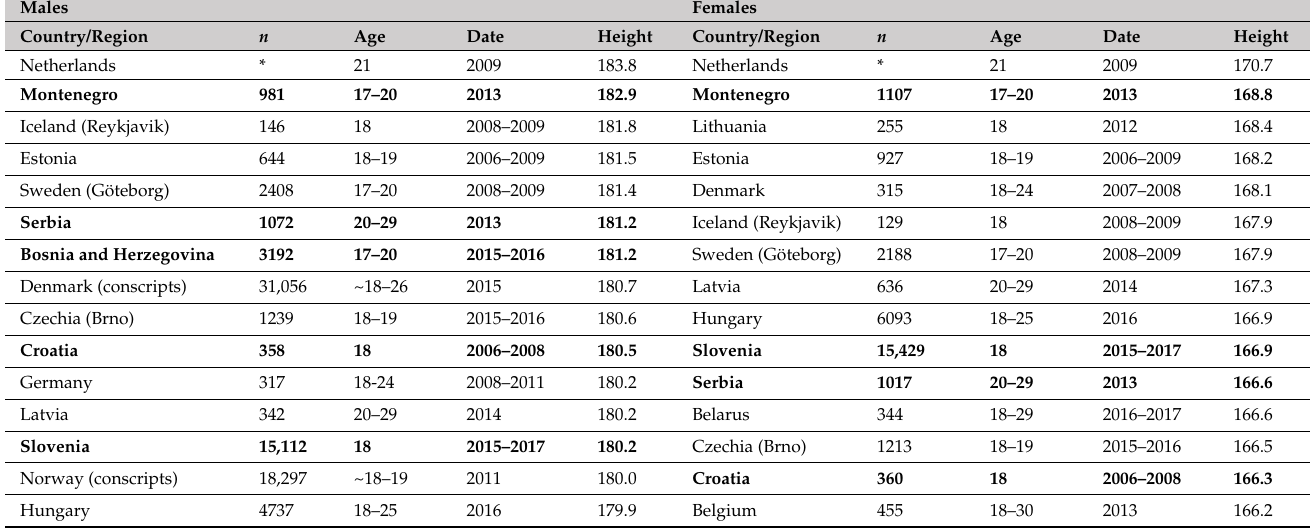
Table 2. Mean height by country (top 15 tallest countries). Countries of the former Yugoslavia are highlighted in bold. Note: The mean height of young women in Bosnia and Herzegovina was not measured but it should be similar to that of Serbian women (~167 cm). This list does not include sub-Saharan Africa but with the possible exception of South Sudan, there are no countries that could influence this ranking. For sources, see